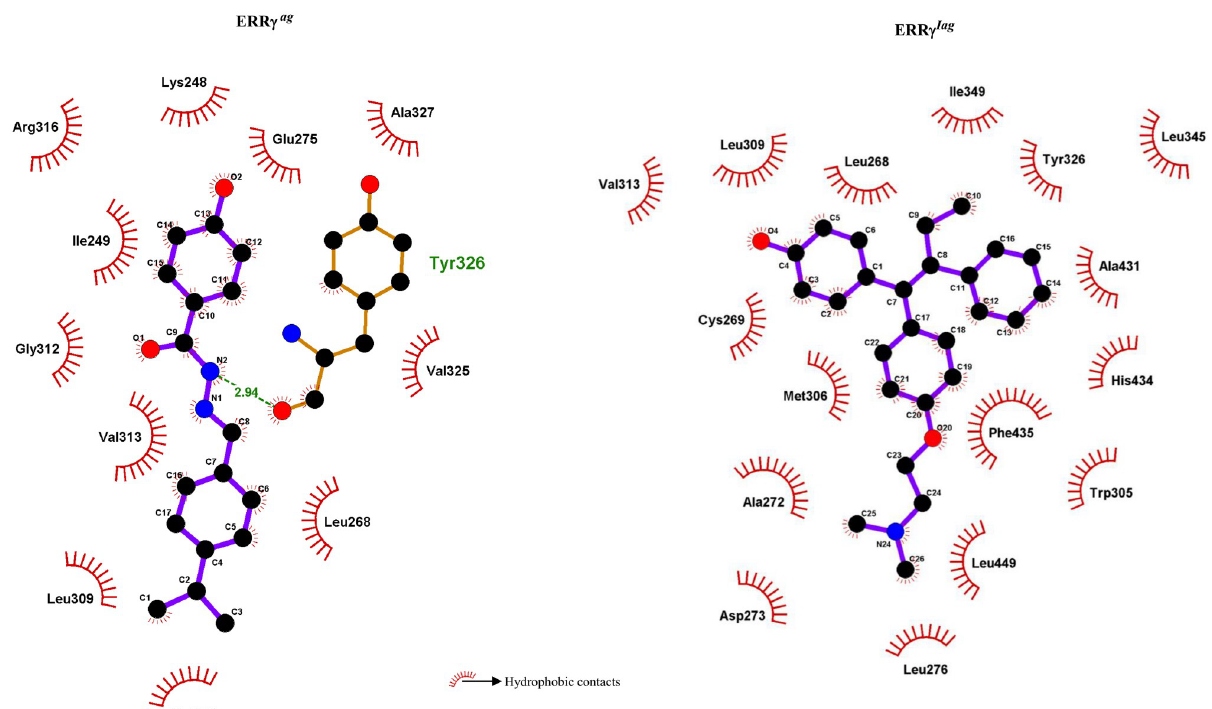
Fig 5. Interaction analysis: The 2D interaction pattern between agonist/inverse agonist and ERR γ .